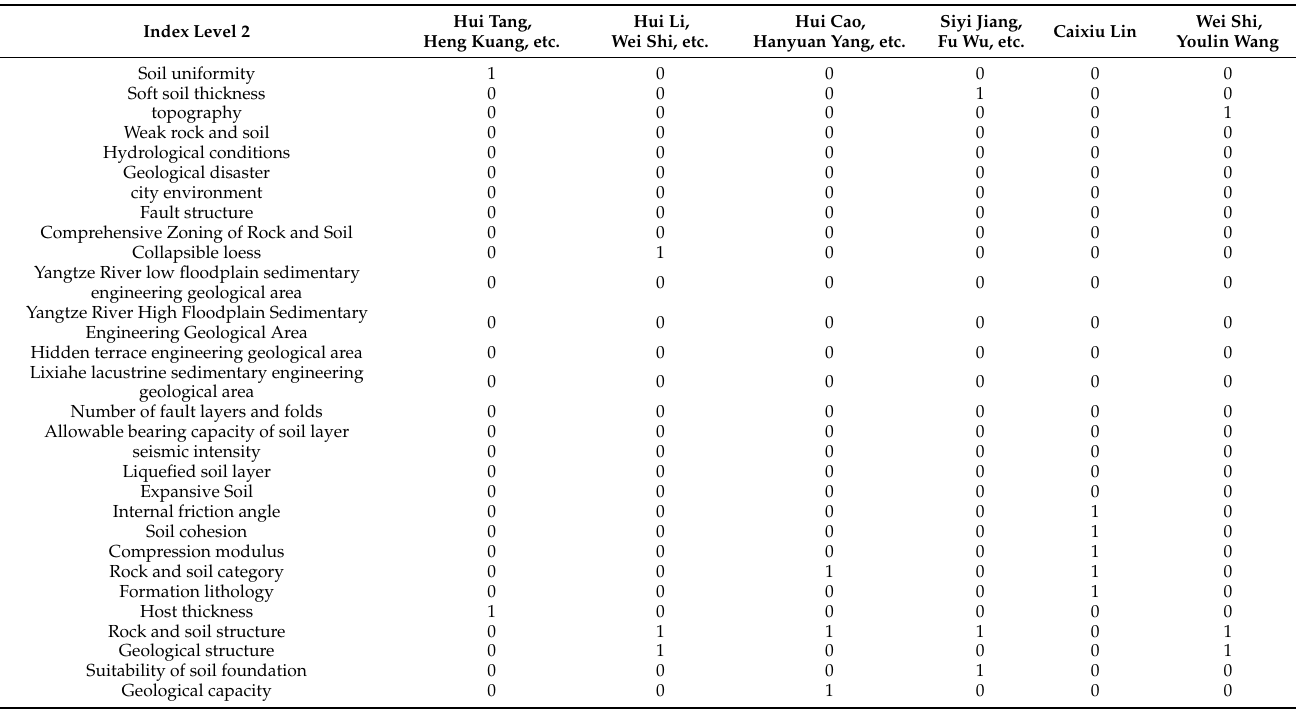
Table A14. Second level index binarization